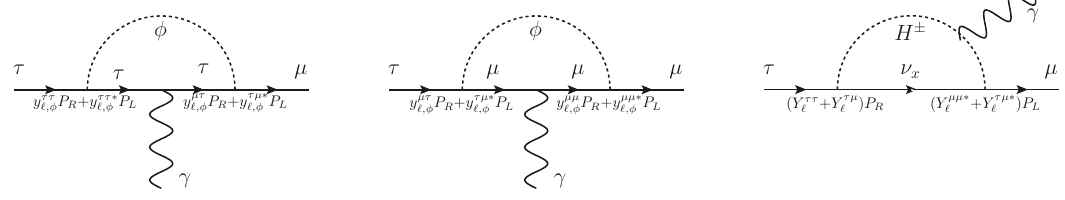
Figure 6. The one-loop diagrams contributing to (cid:28) with (cid:13)avor violating Yukawa couplings Y (cid:28)(cid:22)